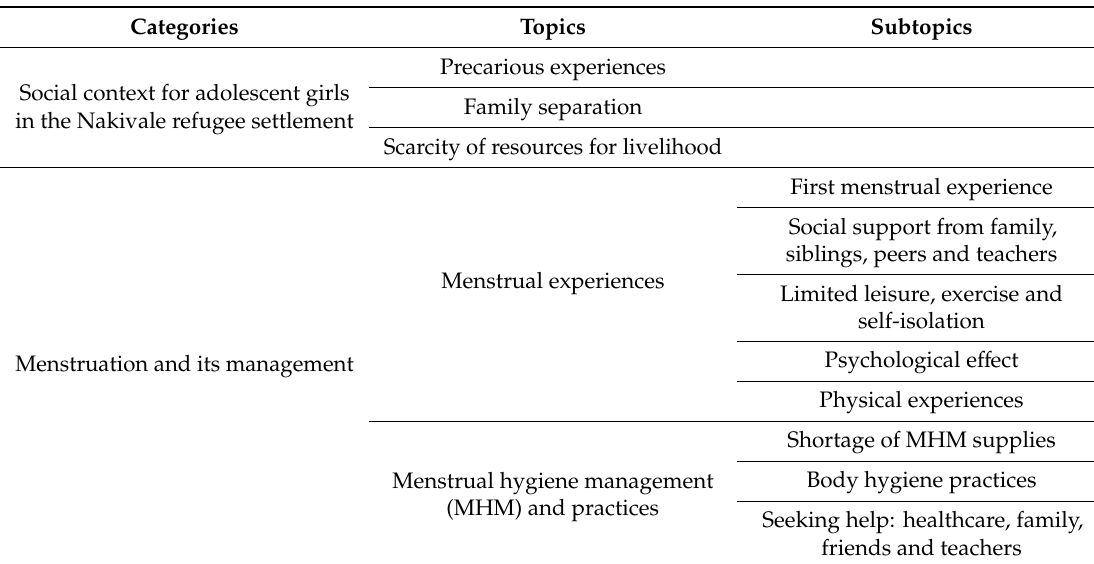
Table 1. Topics and subtopics that emerged from the data collected during interviews and focus group discussions